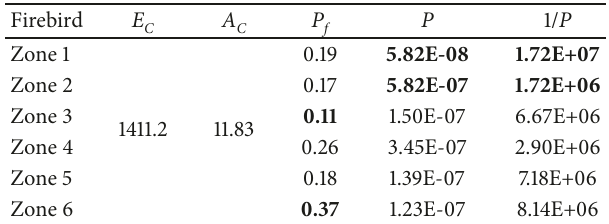
Table 6: Results for Firebird.